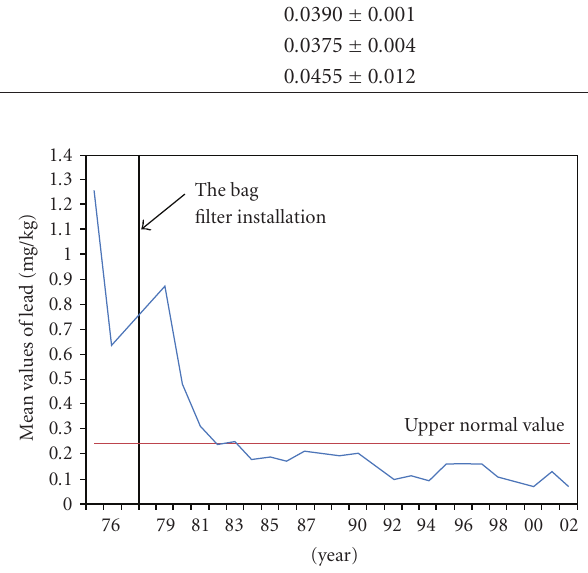
Figure 2: Mean concentration of lead in the blood of cows before (1975-1976) and after the installation of bag filter